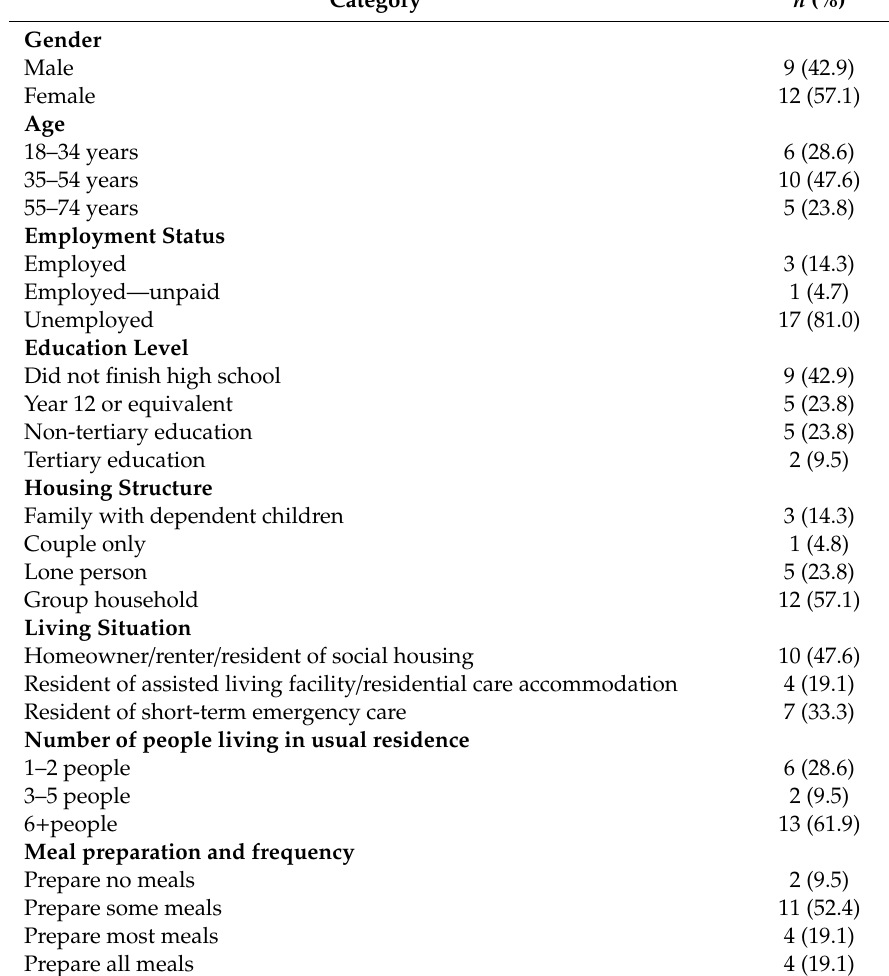
Table 2. Demographic characteristics of NEST pre-post survey participants ( n =